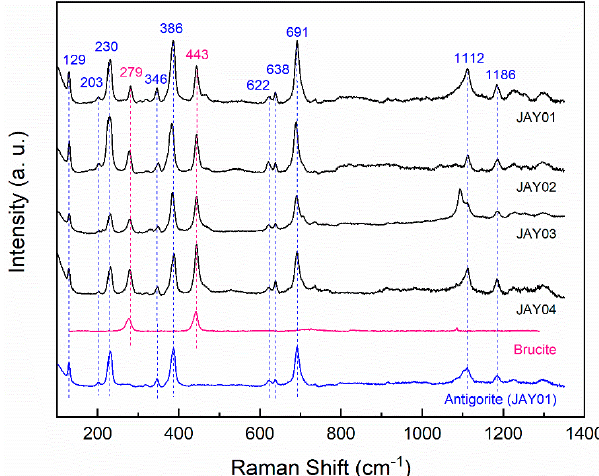
Figure 7. Typical Raman spectra of the brucite grains. Reference spectra for serpentine (blue) and brucite (pink) are respectively from Figure 6 (JAY01) or downloaded from the RRUFF Project website (http://rruff.info). Due to the small grain sizes of the brucite, its Raman spectra have been contaminated by nearby antigorites. To illustrate clearly, only one Raman spectrum is shown for each sample (labeled with the text next to the spectrum), although multiple Raman spectra have been collected.